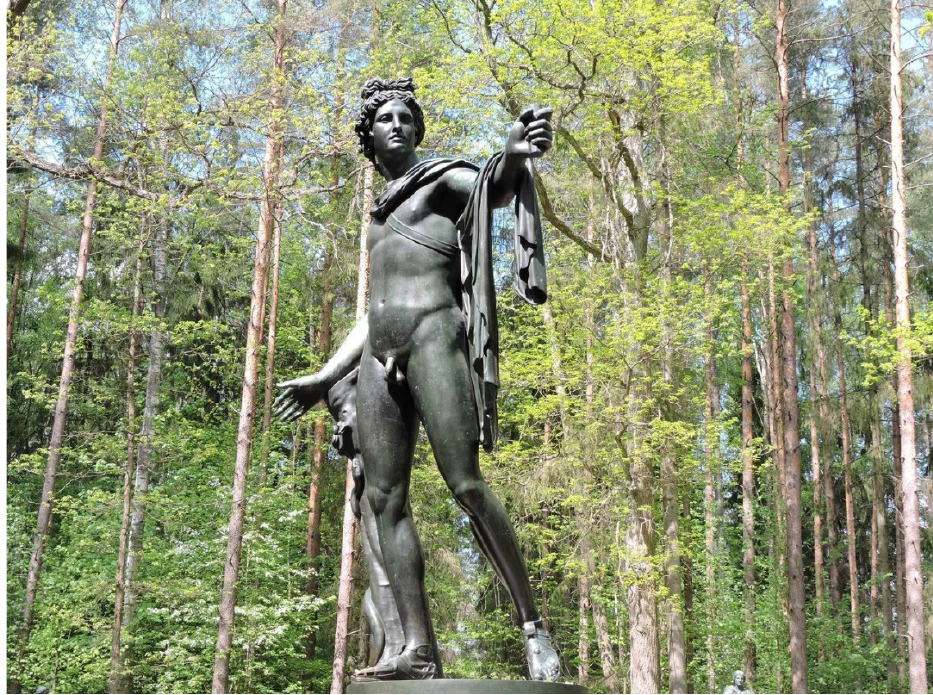
Figure 3. Apollo Belvedere (a bronze copy). Pavlovsk, near Saint Petersburg.